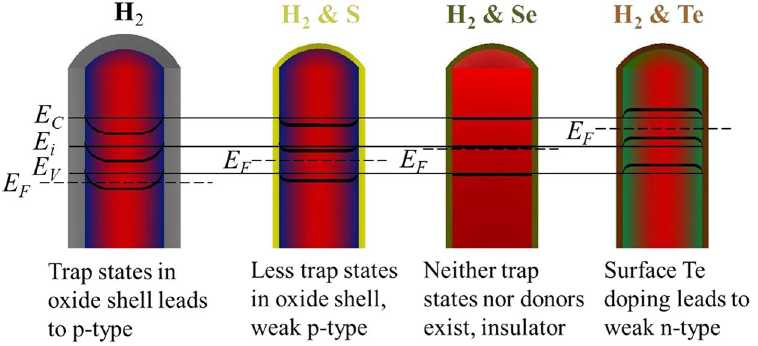
Figure 5. Cross-sectional view of thin GaAs NWs grown without or with different in-situ chalcogen passivation and the corresponding equilibrium energy band diagram at the zero gate